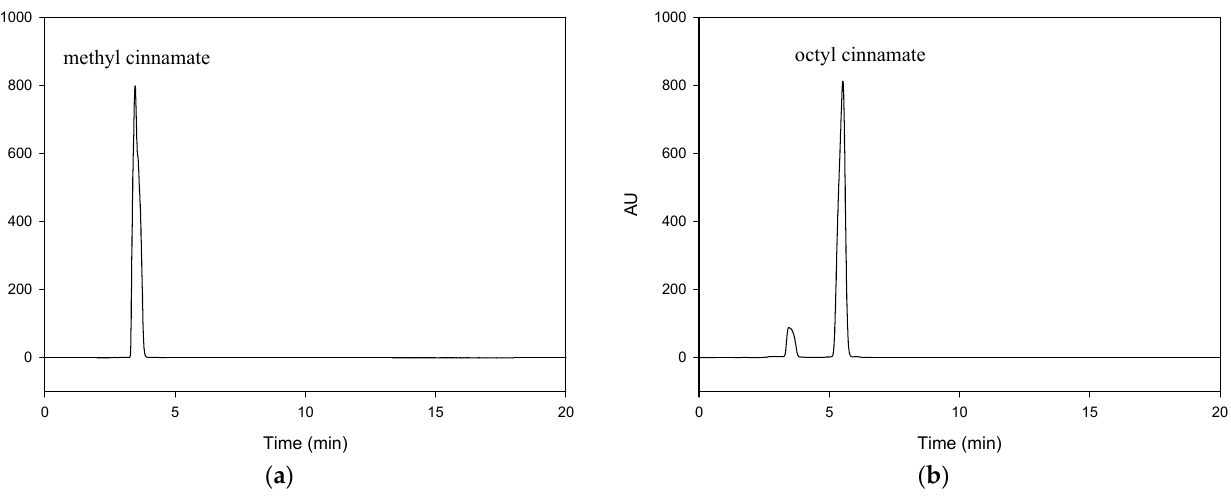
Figure 1. HPLC analysis of the reaction mixture ( a ) before and ( b ) after lipase-catalyzed transester- ification reaction.